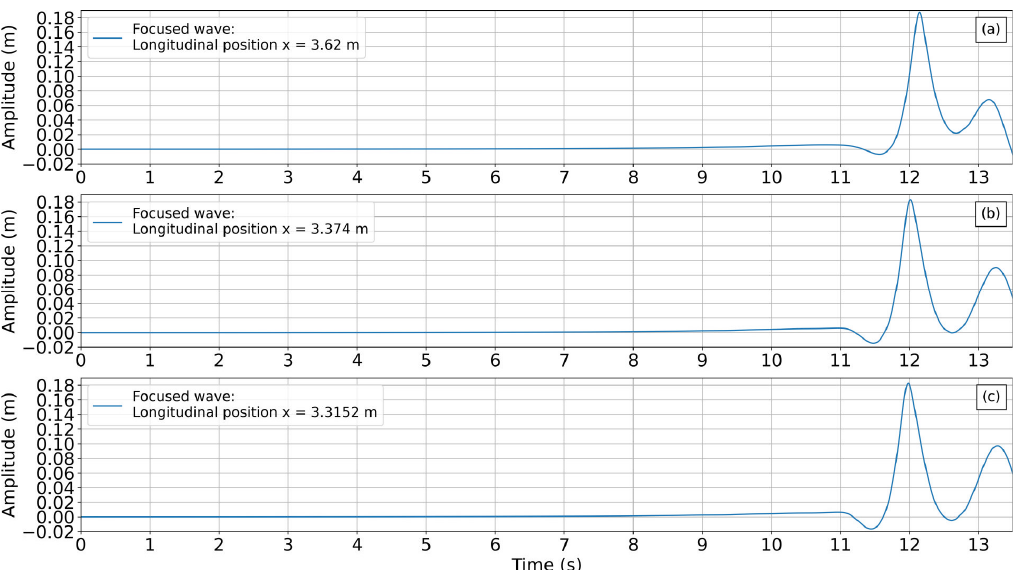
Figure 10. Temporal waveform of the focused wave at the longitudinal locations of ( a ) x = 3.62 m, ( b ) x = 3.374 m and ( c ) x = 3.3152 m.